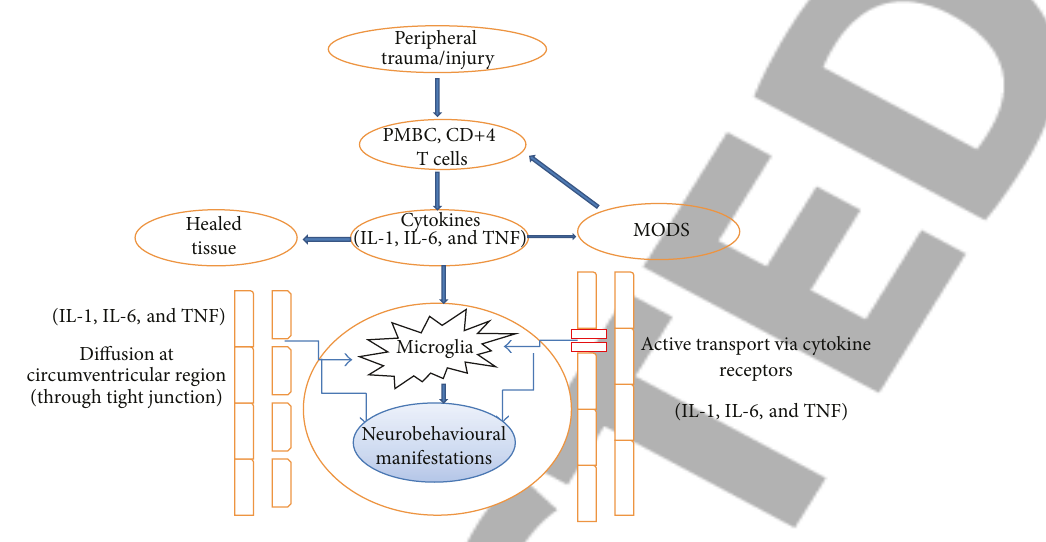
Figure 1: Release and activation of peripheral cytokines from PMBC; mechanism of cytokines transport across the blood brain barrier; IL-1, IL-6, and TNF after crossing BBB stimulate microglia to secrete endogenous cytokines as well as affect neuronal cell/transmission directly. (PMBC—peripheral mononuclear blood cells, MODS—multiorgan dysfunction syndrome, TNF—tissue necrosis factor, IL-1—interleukin 1, and IL-6—interleukin 6).